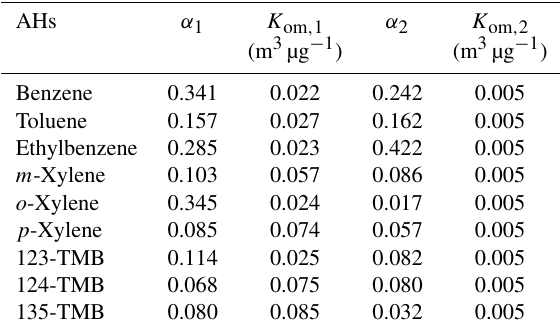
Table 1. Fitting yield curve parameters of two-product semi- empirical